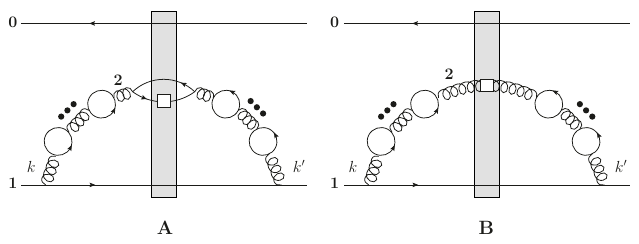
Figure 9 . Quark-loop corrections for the polarized gluon emission diagram from eq. (5.13a). The diagram contributes to the DLA+SLA evolution kernel. The ellipsis indicate a sum over all L possible numbers of quark bubble corrections, from zero to